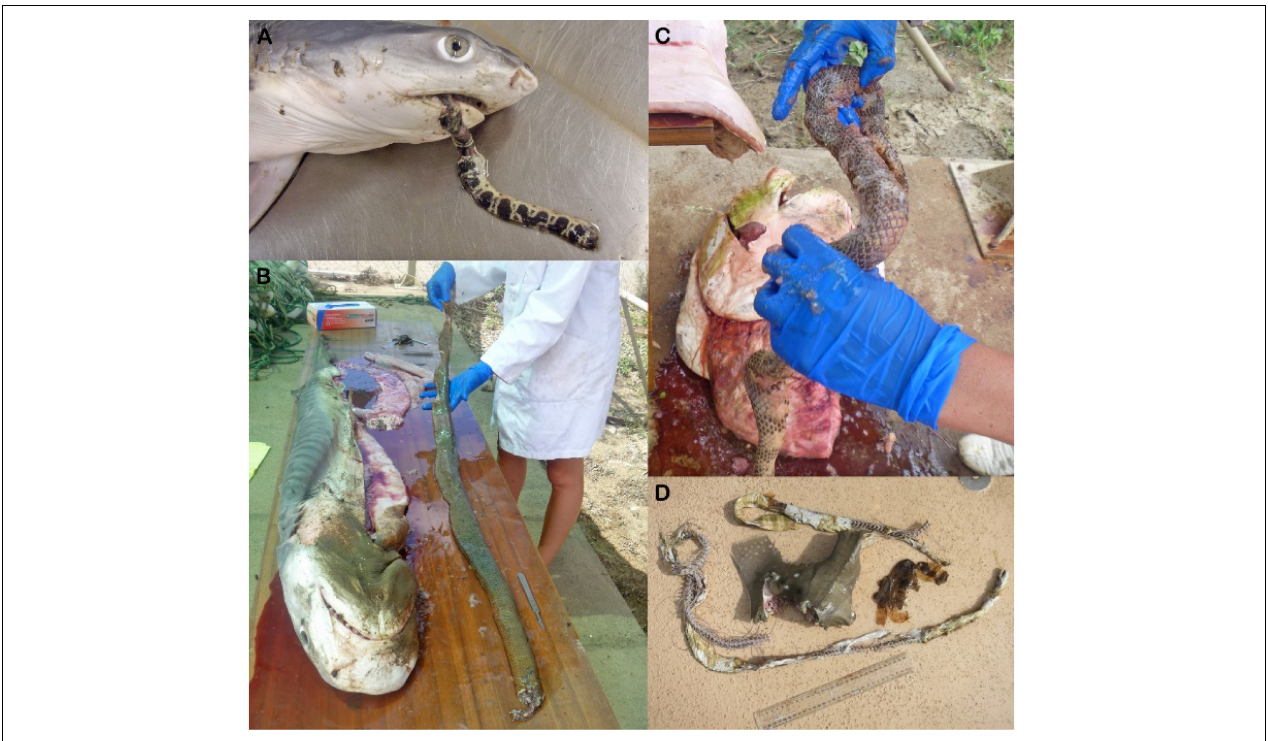
FIGURE 6 | Evidence of predation of sea snakes by tiger sharks ( Galeocerdo cuvier ): (A) Olive-headed sea snake Hydrophis major , (B) Olive sea snake Aipysurus laevis , (C) Dubois’ sea snake Aipysurus duboisii , and (D) Elegant sea snake Hydrophis elegans. Photos: (A–C) from Queensland, Australia by Bonnie Holmes, D from Western Australia, Australia provided by Department of Primary Industries and Regional Development.